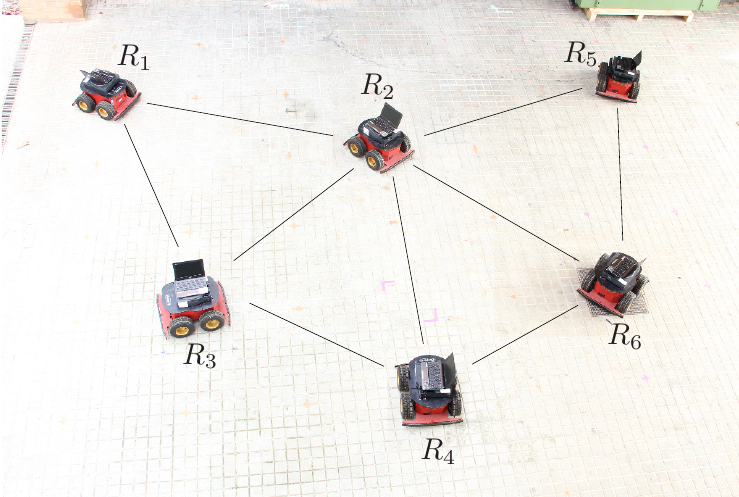
Figure 8. A fleet or robots. Each robot is equipped with an infrared sensor to measure the distances to nearby teammates. The lines in the figure represent the distances actually measured. The relative orientation of the triangles is given by cameras mounted on the